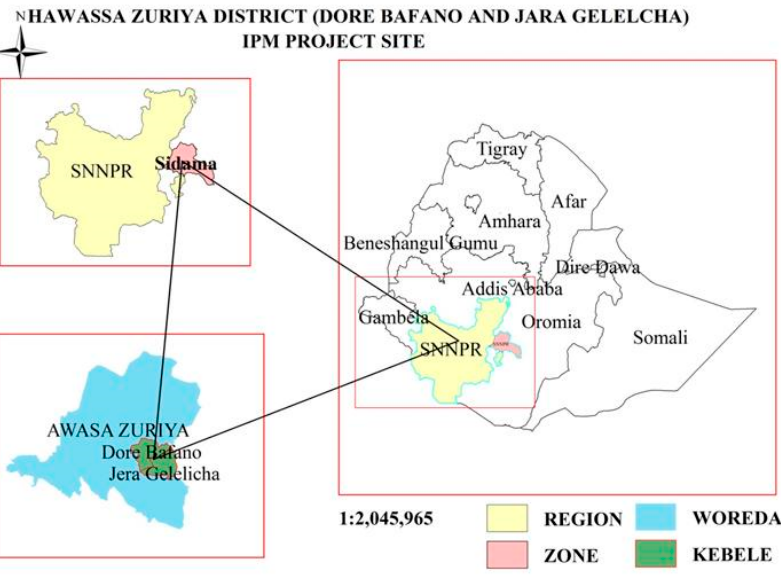
Figure 1. A map showing the Hawassa district and the study sites in Ethiopia.